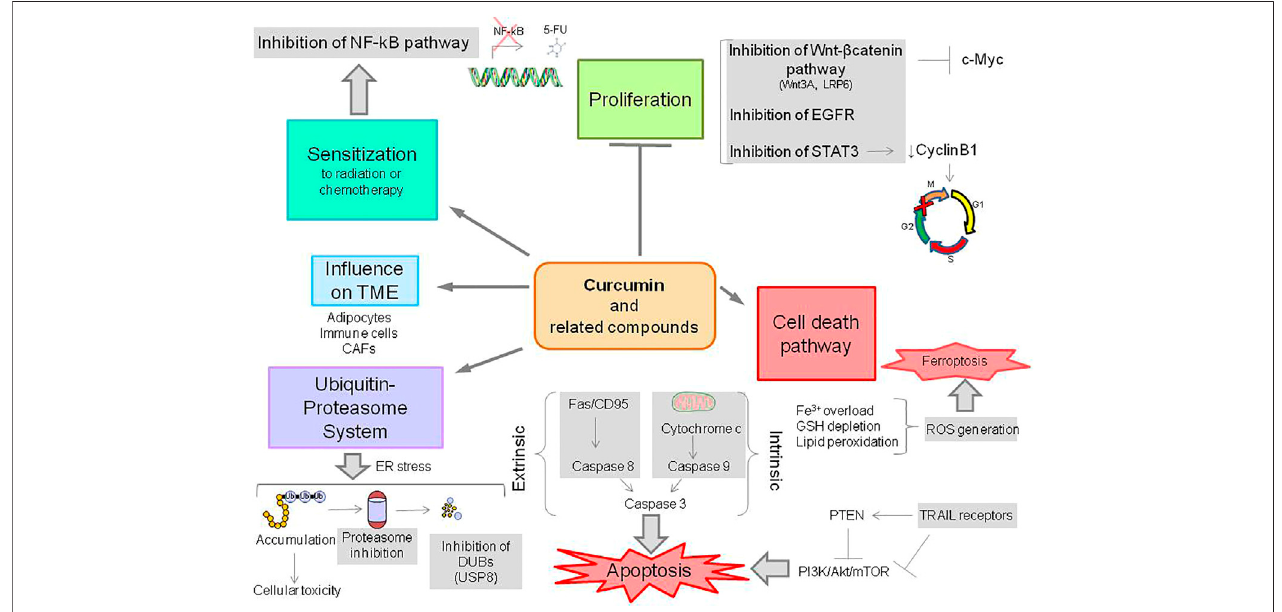
FIGURE 2 | Overview of the biological activities of curcumin and related compounds. CAFs, cancer-associated fi broblasts; DUBs, deubiquitinases; ROS, reactive oxygen species; GSH, reduced glutathione; 5-FU, 5- fl uorouracil.